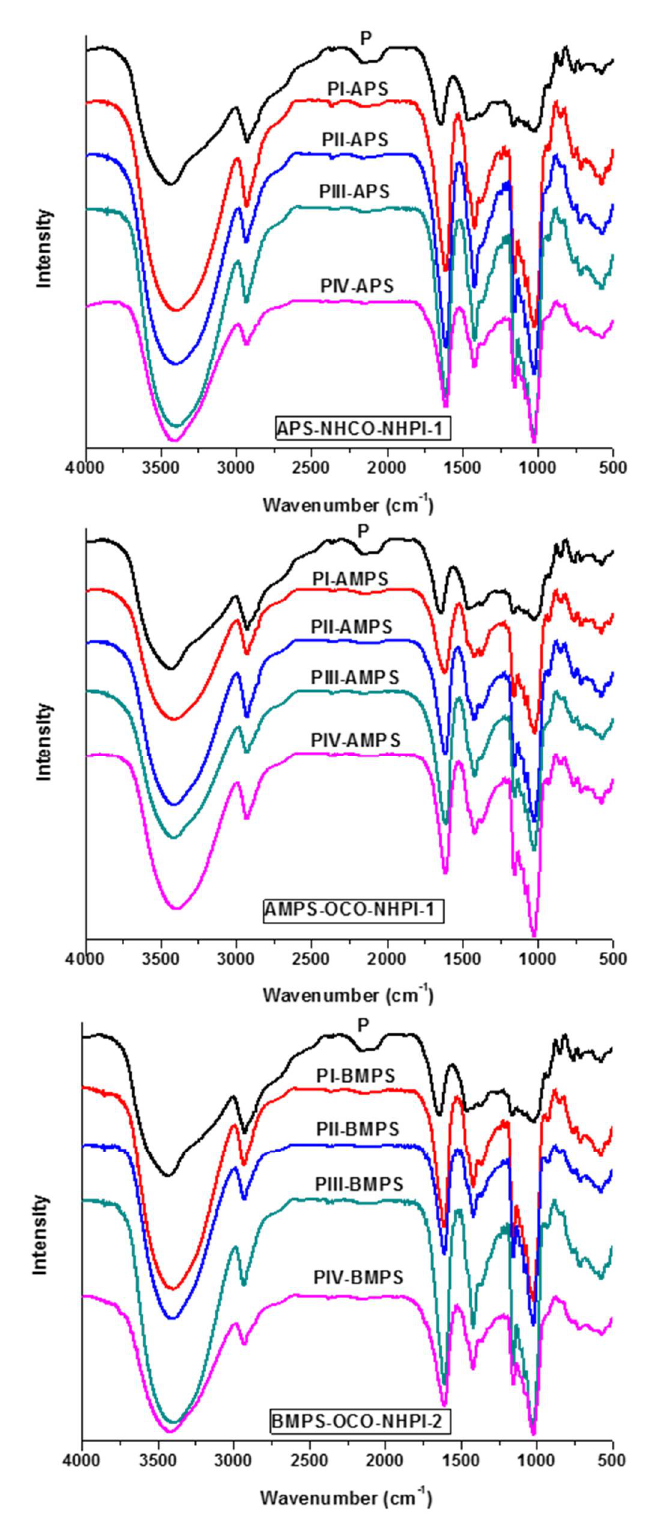
Figure 5. FTIR spectra of pullulan oxidized in the presence of NHPI-supported catalysts